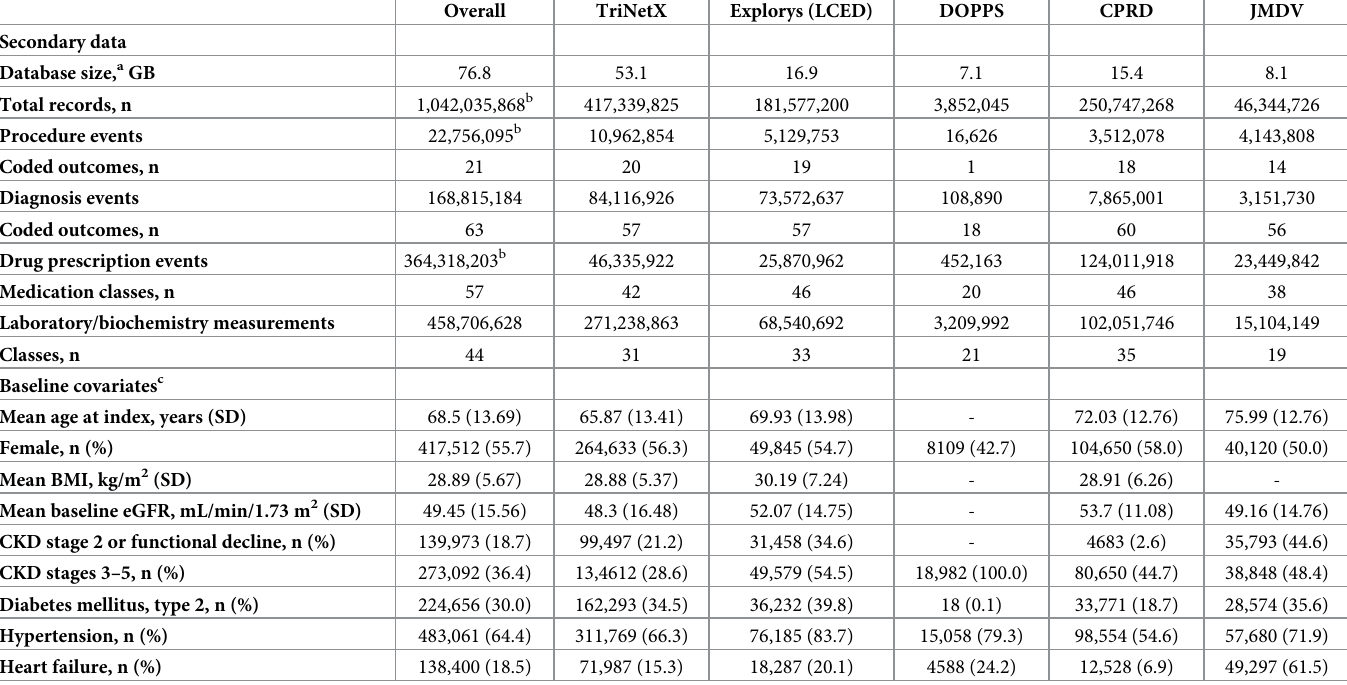
Table 2. Secondary data and baseline covariates of patients included in DISCOVER